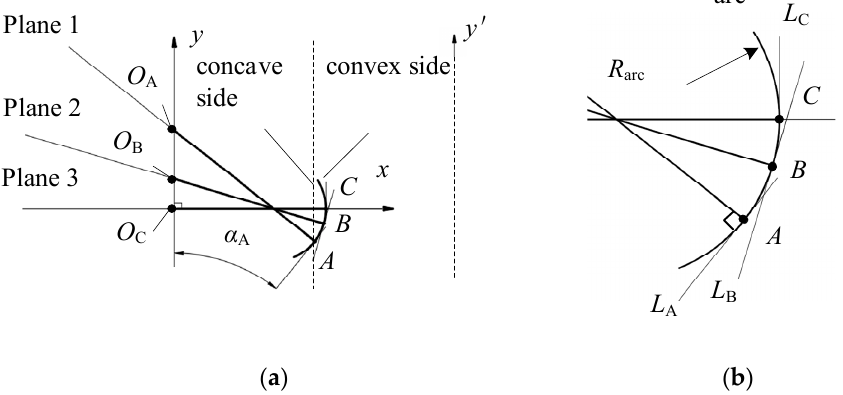
Figure 7. The extreme value of the radius of curvature at any point on the circular arc surface. ( a ) The cross-sectional view of circular arc rotation; ( b ) magnified cross-sectional view of circular arc.